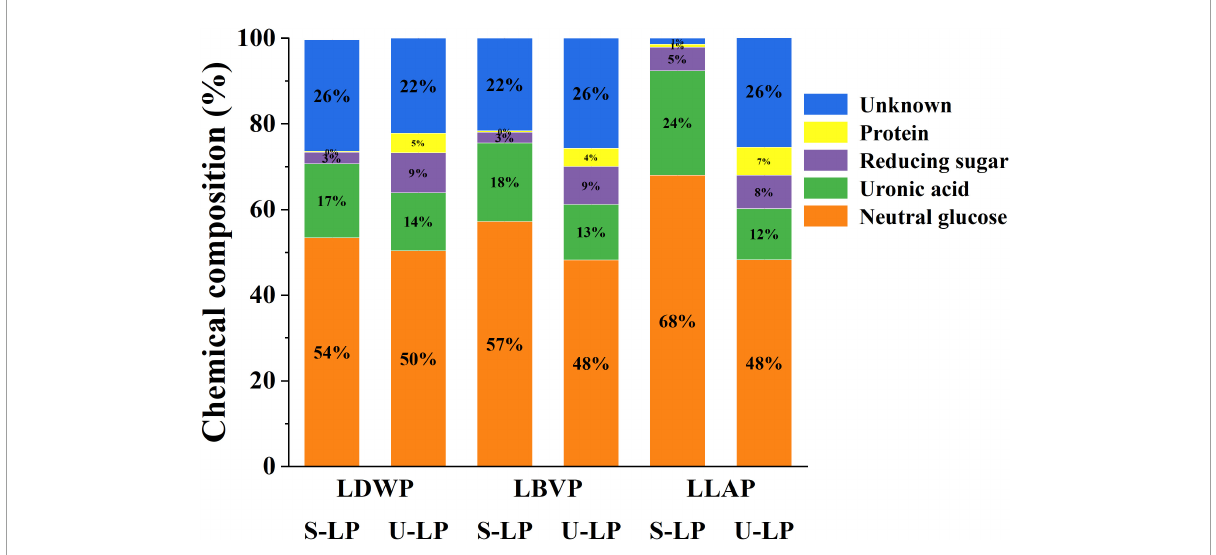
FIGURE1 The chemical composition (%) of three lily polysaccharides extracted by different extraction methods.